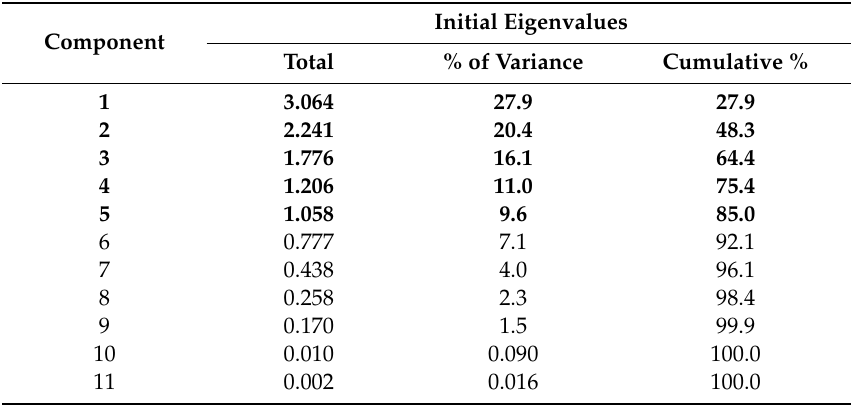
Table 3. Component matrix of principal components.